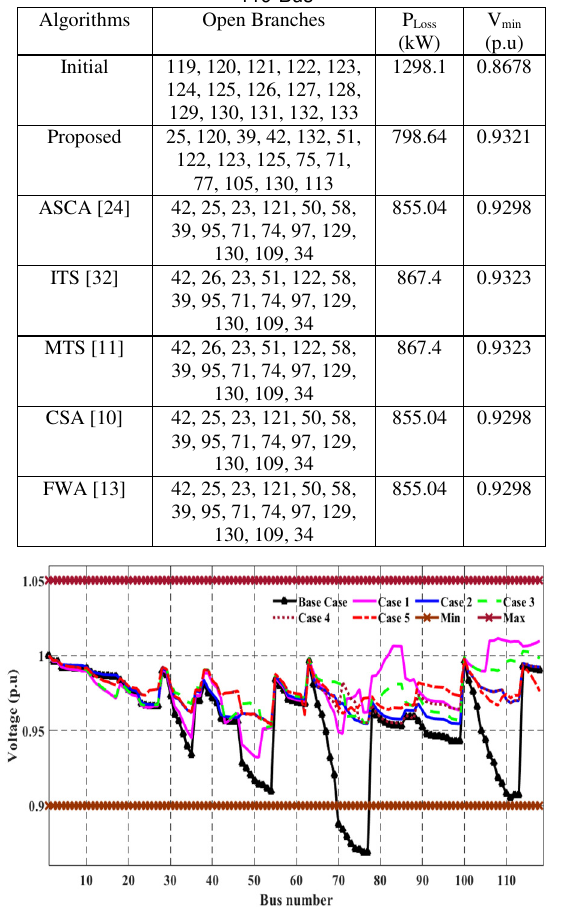
Table 9: Simulation Results in Comparison of Case 1 for 119-Bus Algorithms